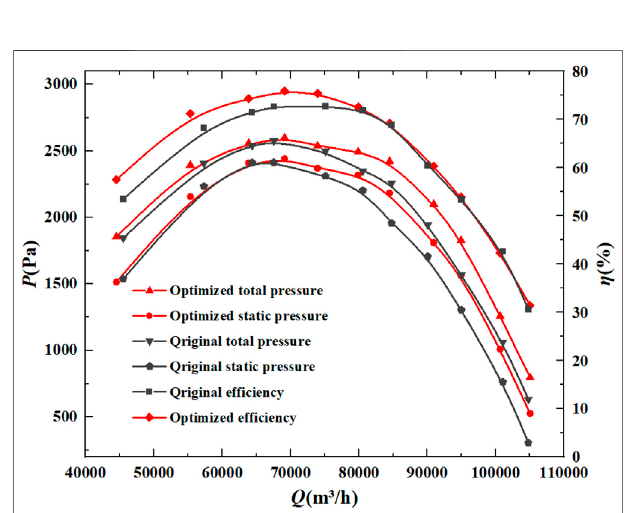
FIGURE 11 | Fan performance curves original and optimized.